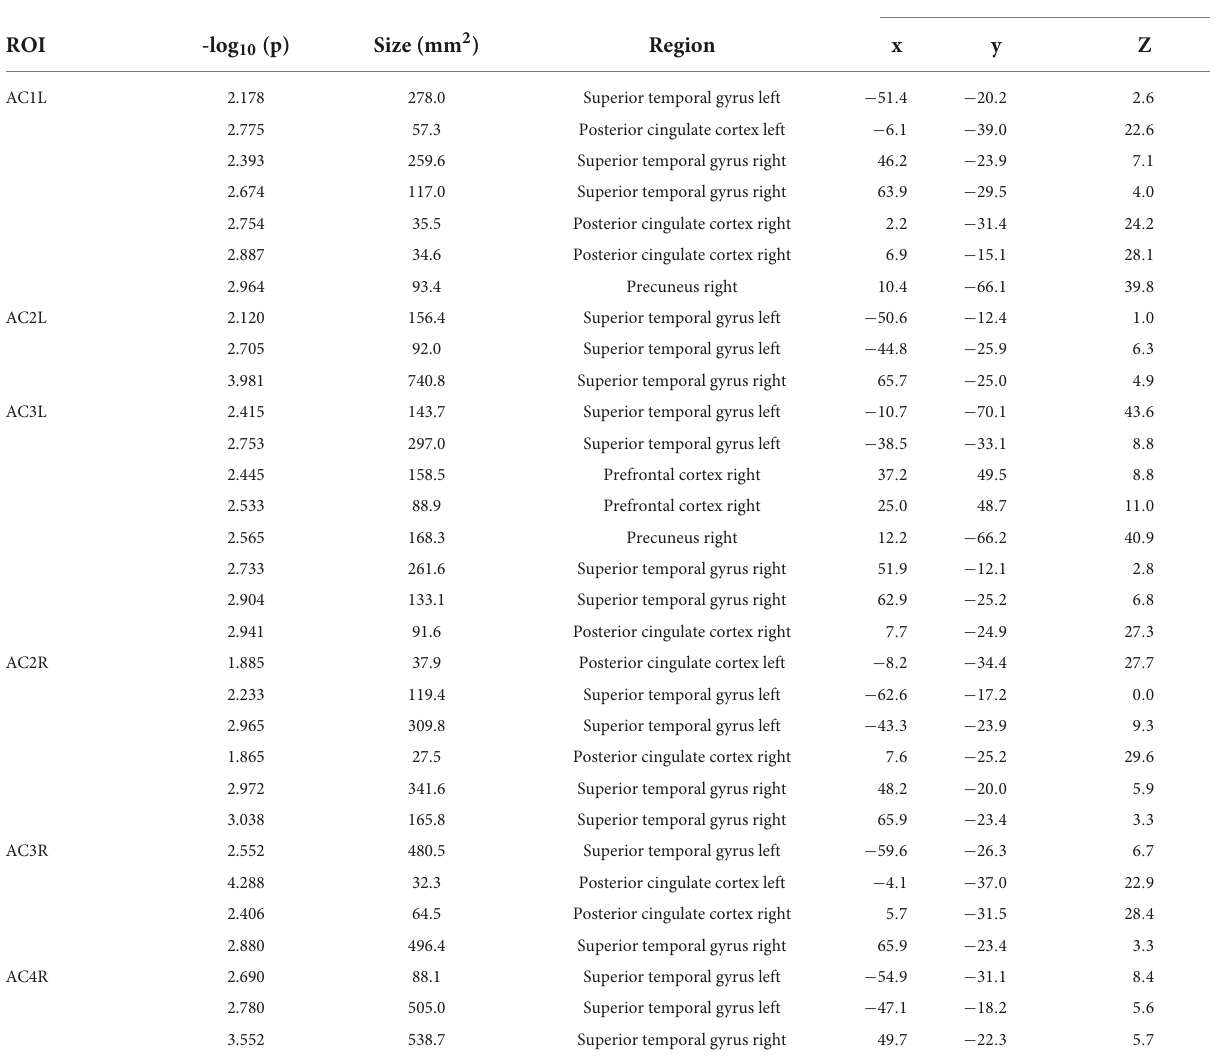
TABLE 2 Results of functional connectivity